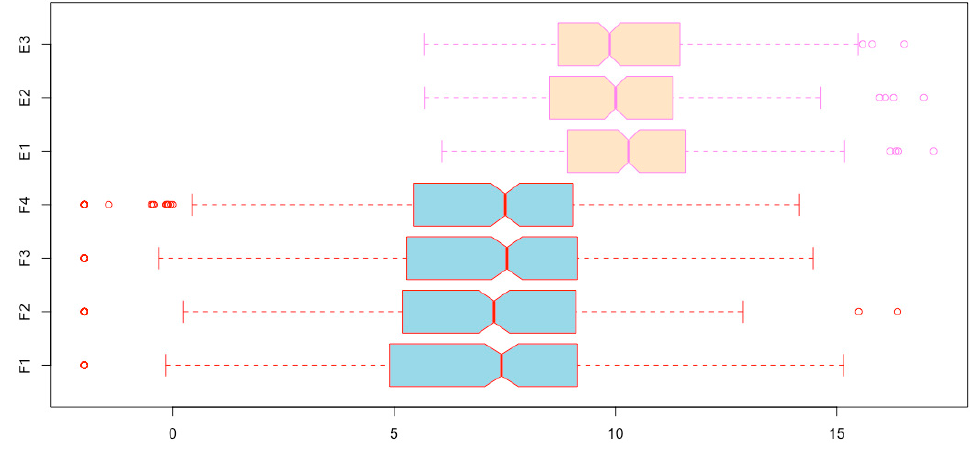
Figure 11. Assign shorter sample names for the horizontal boxplots using the R function names() .